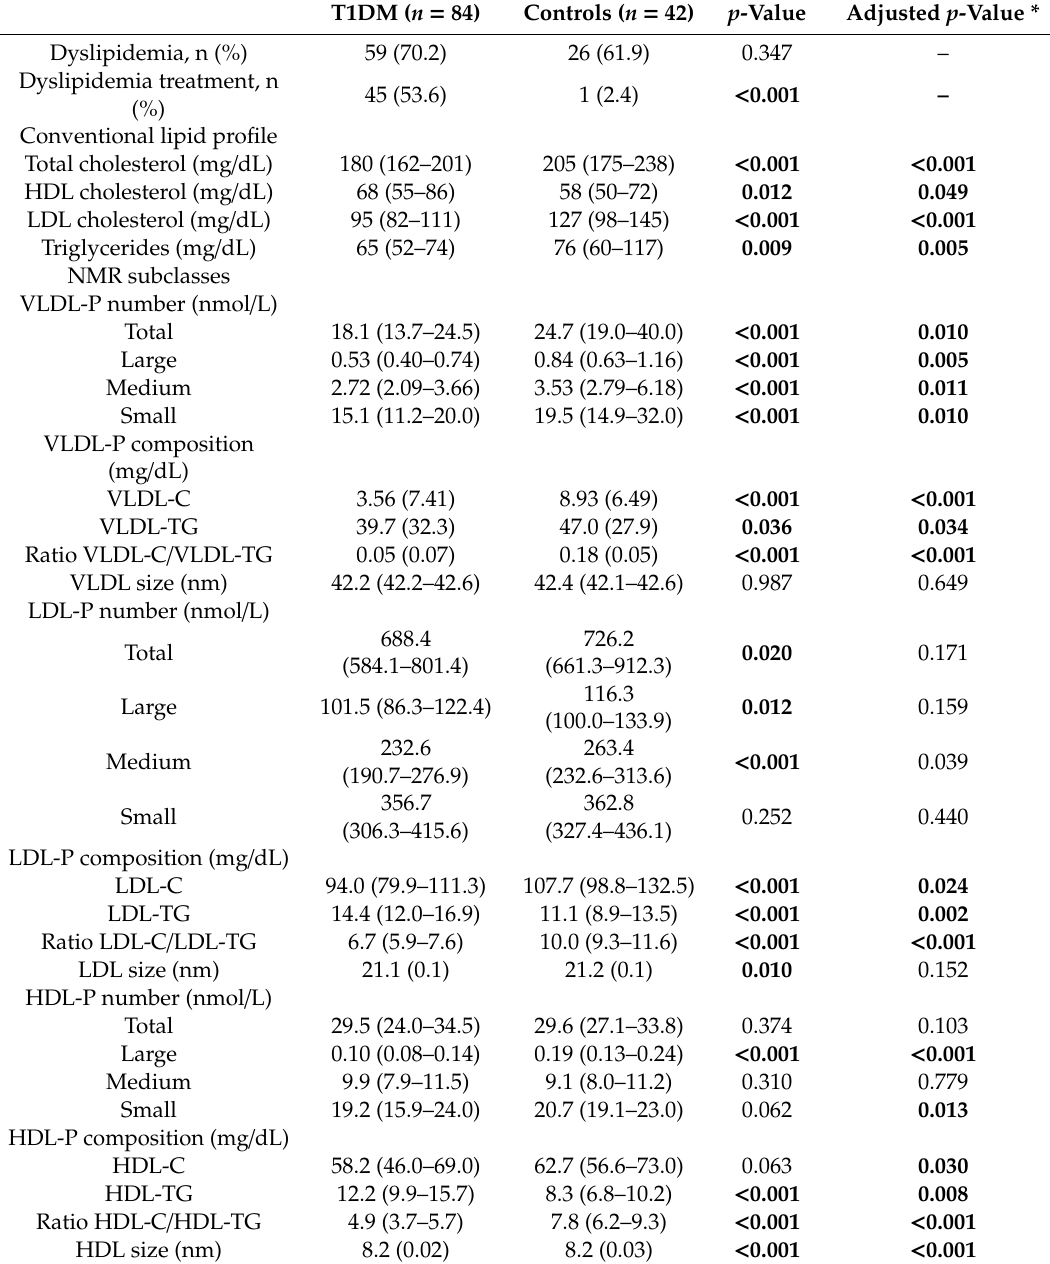
Table 2. Conventional lipid profile and NMR-assessed lipoprotein subclass profile of the study